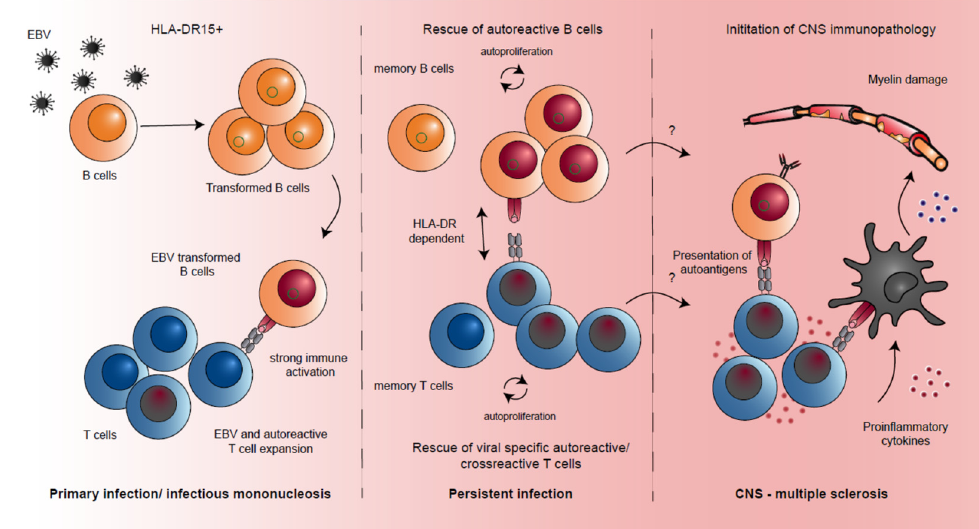
Figure 1. Potential interaction mechanisms between EBV infection and HLA-DR15 for the develop- ment of MS. HLA-DR15 + carriers show a reduced EBV-specific immune control, with higher viral loads and increased T cell activation. The strong immune activation during primary EBV infection could allow the activation and expansion of autoreactive T cells by insufficiently controlled EBV- transformed B cells (autoreactivity depicted as red nuclei). Accumulating EBV-transformed B cells could activate cross-reactive T cells, favoring their survival and expansion, in an HLA-DR-dependent manner. By a yet unknown mechanism, autoproliferative lymphocytes might home to the CNS, where possibly EBV-transformed B cells could act as APCs for the cross-reactive T cells that then activate myeloid cells with proinflammatory cytokines to start the immunopathology seen in MS with myelin